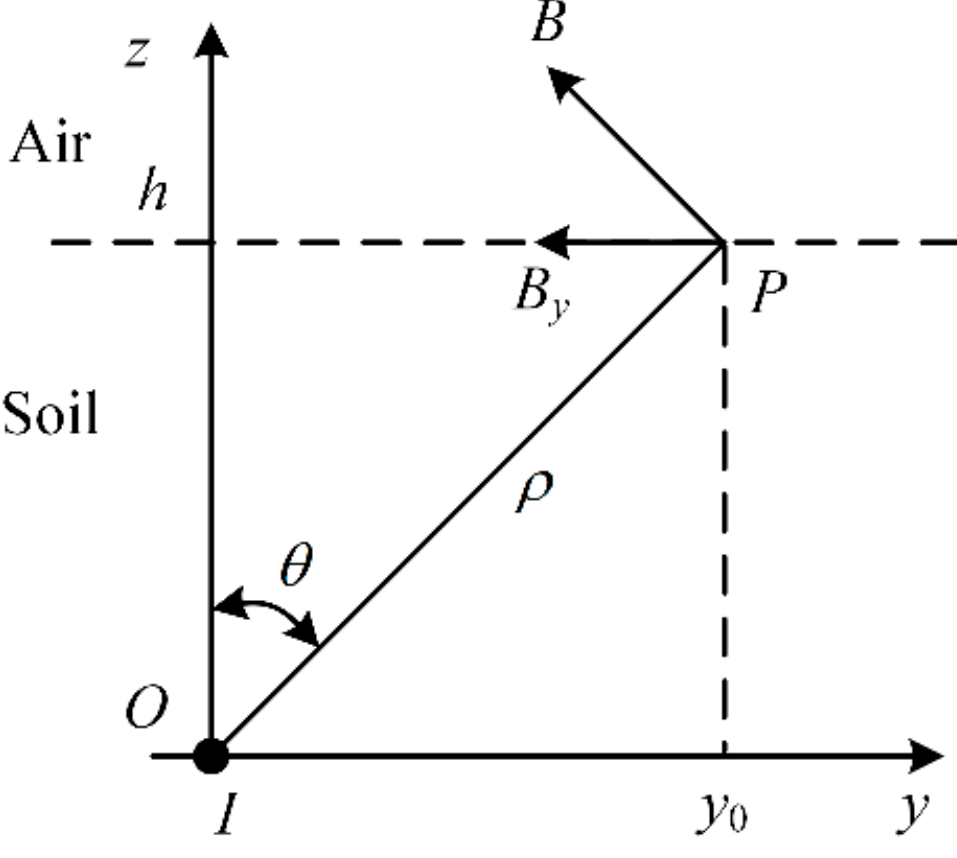
Figure 1. Single conductor current-carrying model.